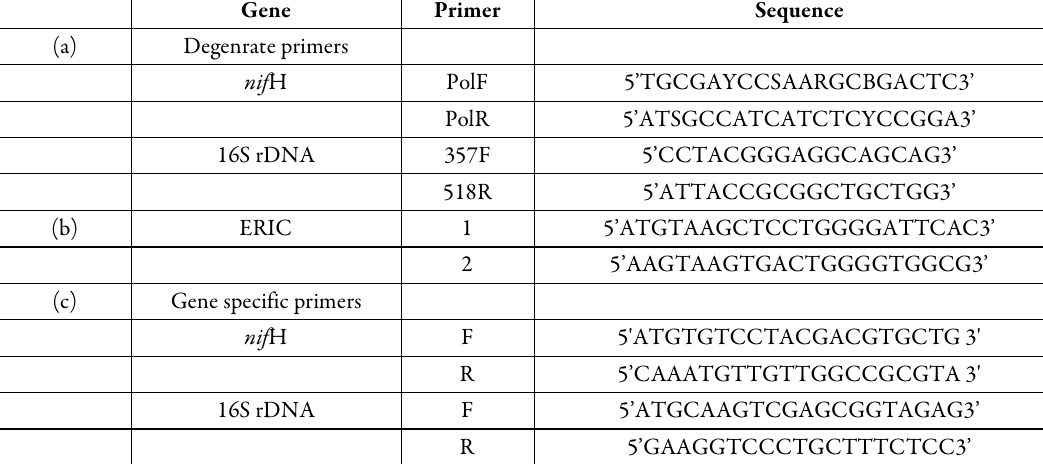
Table 1. Details of primer used Gene Primer